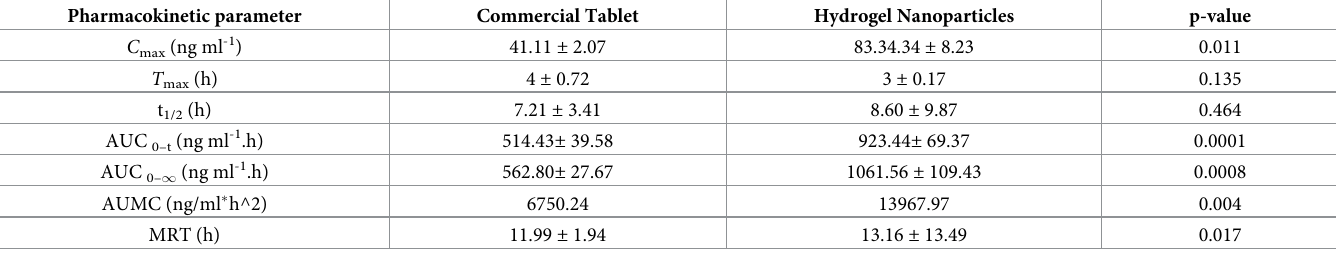
Table 8. Mean values of pharmacokinetic parameters of rosuvastatin following administration of oral tablet and oral nanogel in rabbits ( n = 12).